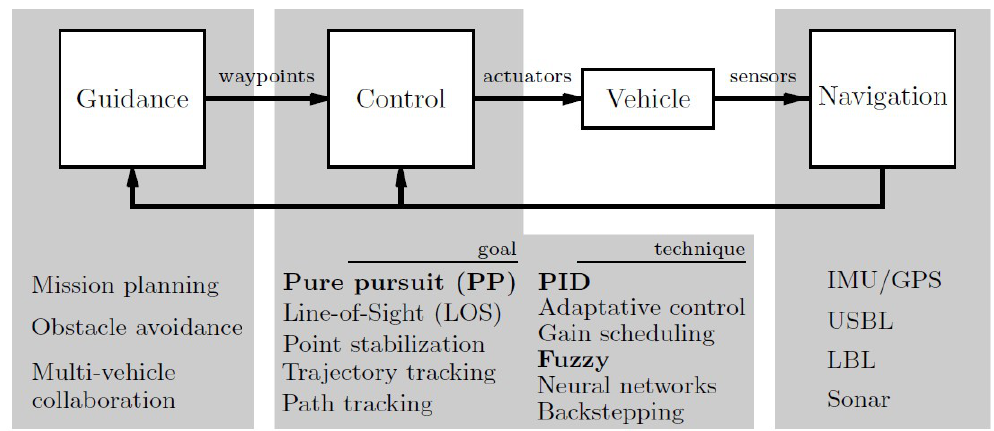
Figure 6. Guidance, navigation and control and the some of the main associated research lines. In bold, those aspects described in greater details in the paper are reported. USBL, Ultra-Short Baseline; LBL, Long